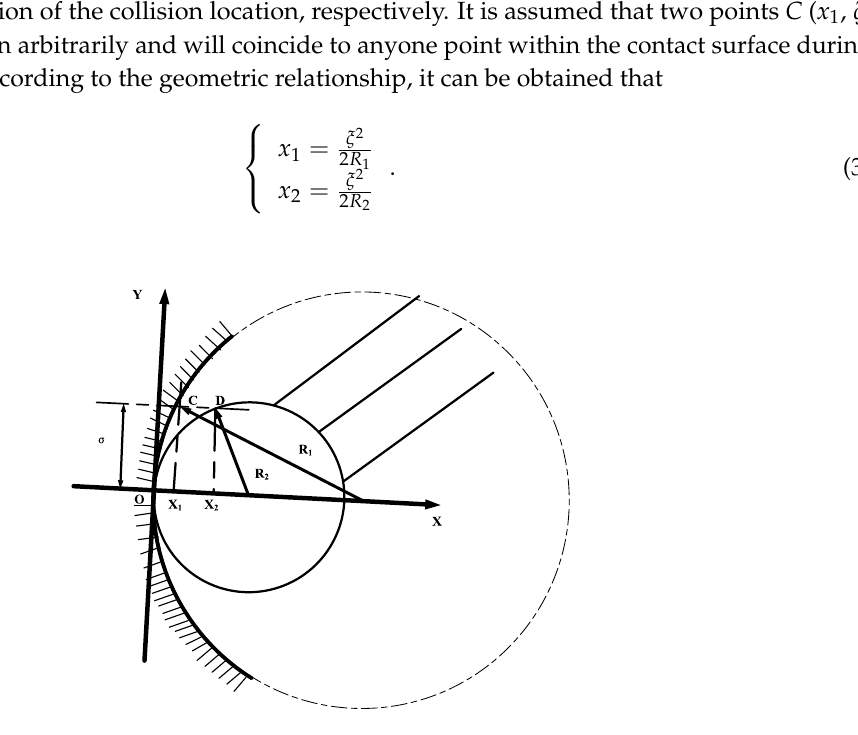
Figure 3. The detailed contact model. And this figure shows the sectional view of the red region in Figure 2.